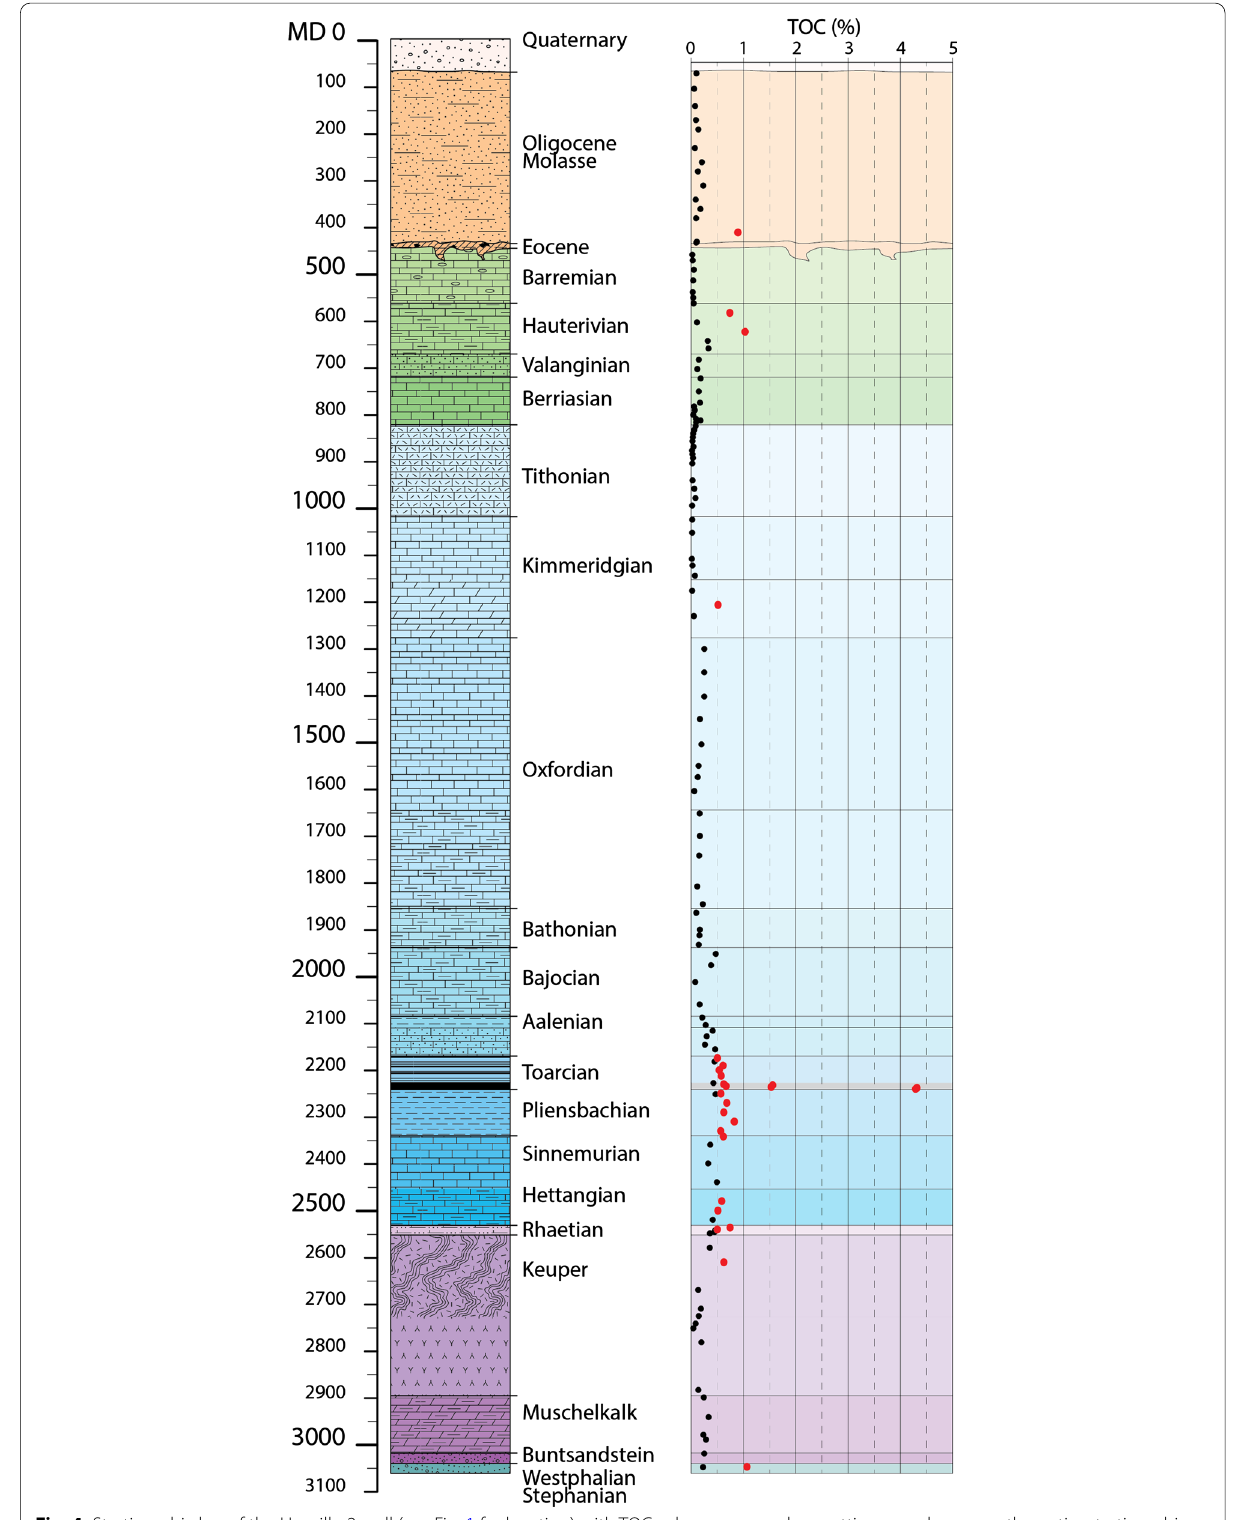
Fig. 4 Stratigraphic log of the Humilly-2 well (see Fig. 1 for location) with TOC values measured on cutting samples across the entire stratigraphic section. Red dots highlight samples where TOC >